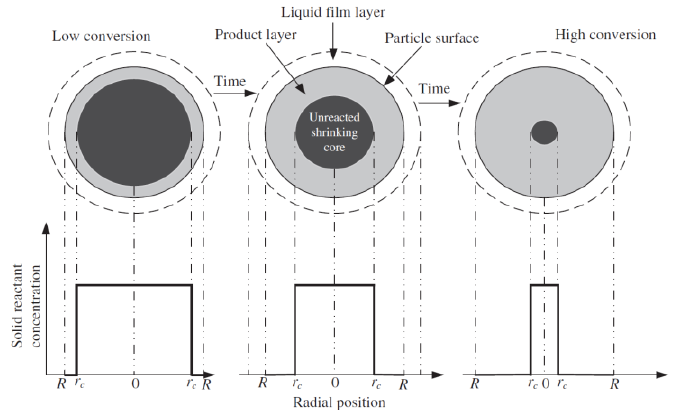
Figure 2. Schematic diagram of the shrinking core model (SCM), according to [17].